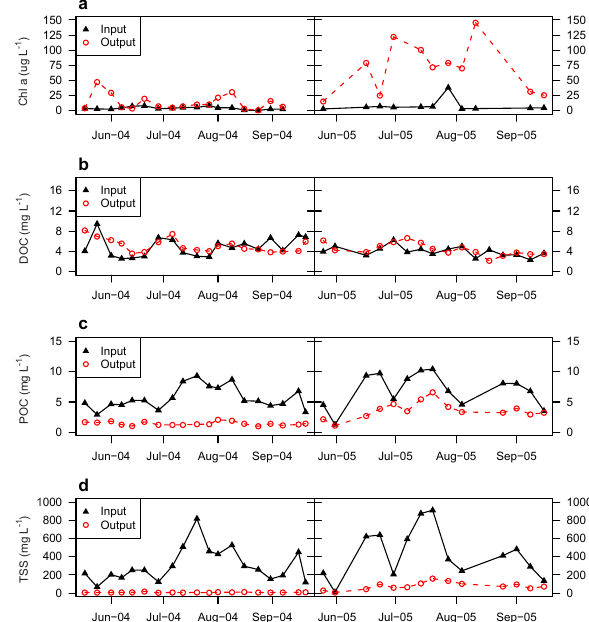
Fig. 3. Inflow and outflow wetland water column concentrations of (a) chlorophyll- a , (b) dissolved organic carbon, (c) particulate organic carbon, and (d) total suspended solids in 2004 and